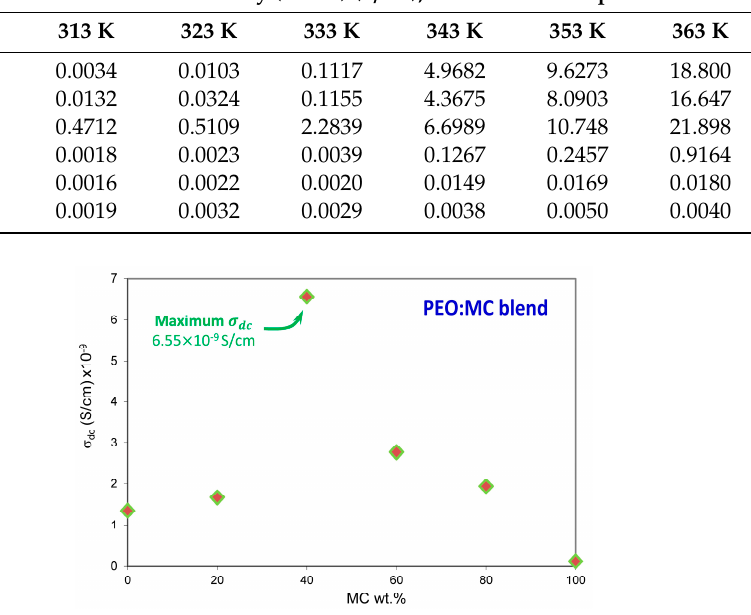
Figure 9. Variation in ambient temperature DC conductivities by MC wt.% in the PEO matrix.